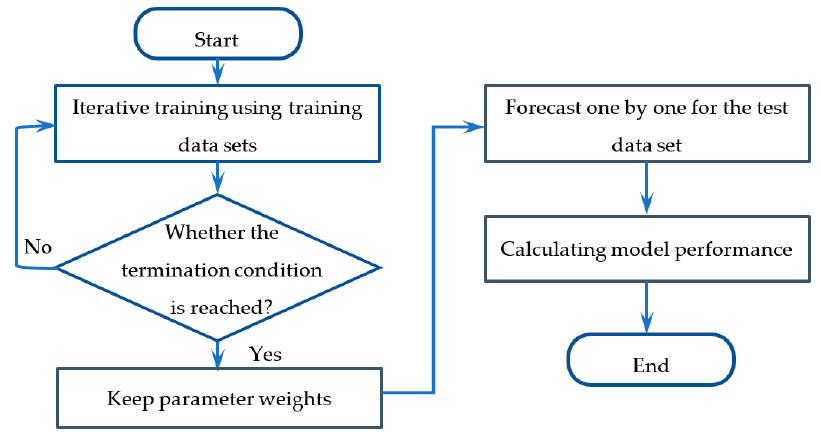
Figure 2. Training flow diagram of the convolutional neural network model.